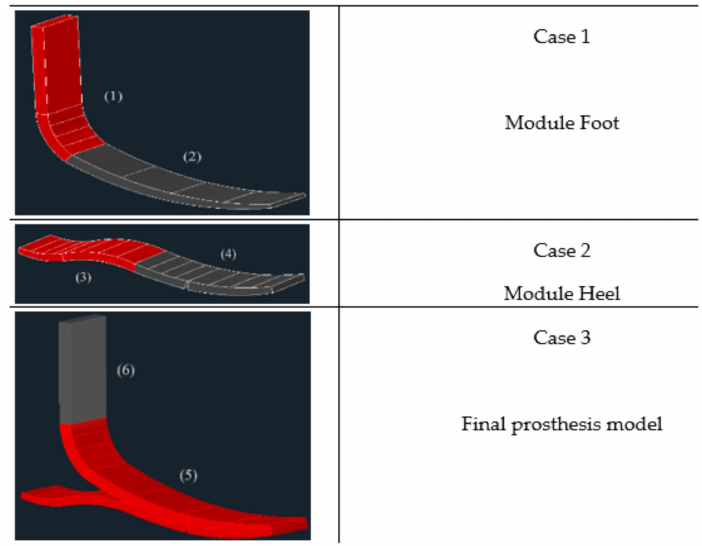
Figure 12. Study cases of prosthesis modules for numerical